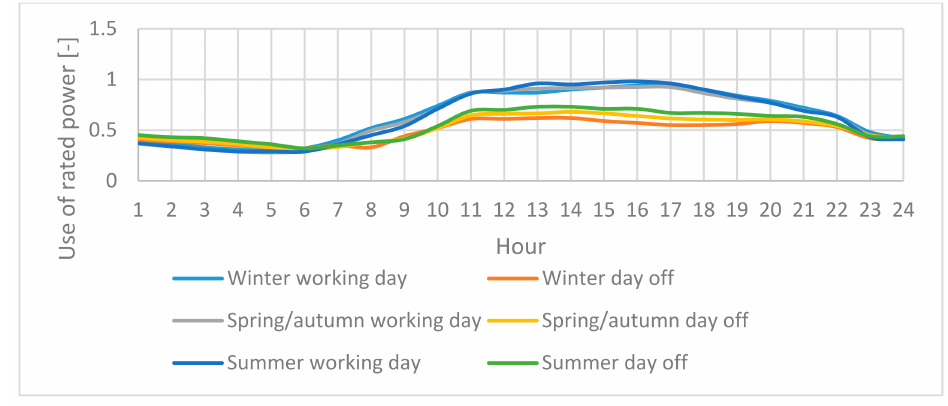
Figure 5. Representative profiles for commercial loads.